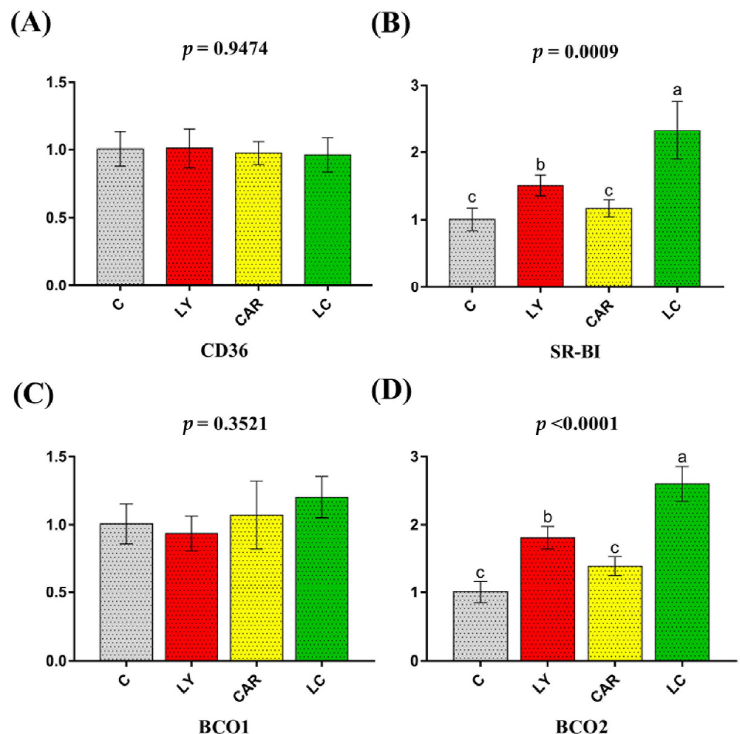
Figure 1. Relative mRNA expression of duodenal genes related to Lycopene uptake. ( A ), CD36; ( B ), SR ‐ BI; ( C ), BCO1; ( D ), BCO2. Data are presented as mean value ± SEM ( n = 3). Values without the same letter (a, b, c) represent statistically significant differences ( p < 0.05). Abbreviations: C, Roosters fed a basal diet; LY, Roosters fed a basal diet supplemented with 400 mg/kg Lycopene; CAR, Roosters fed a basal diet supplemented with 150 mg/kg L-Carnitine; LC, Roosters fed a basal diet supplemented with (400 + 150) mg/kg Lycopene and L-Carnitine in combination.